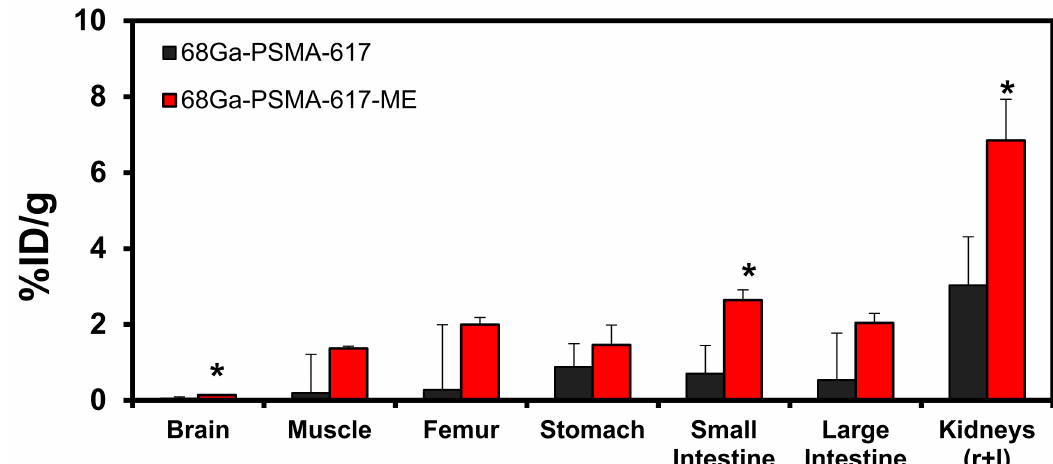
Figure 4. Organ and tissue biodistribution (%ID/g) of [ 68 Ga]Ga-PSMA-617 (black) and [ 68 Ga]Ga-PSMA-617-ME (red) 120 min after intravenous injection. Radioactive organ samples and radioactivity standards were measured using high- performance gamma counting. Results are expressed as mean ( ± SEM; n = 4). * P <